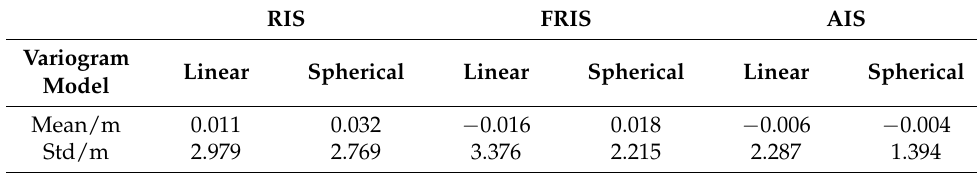
Table 2. Cross validation result for RIS, FRIS, and AIS